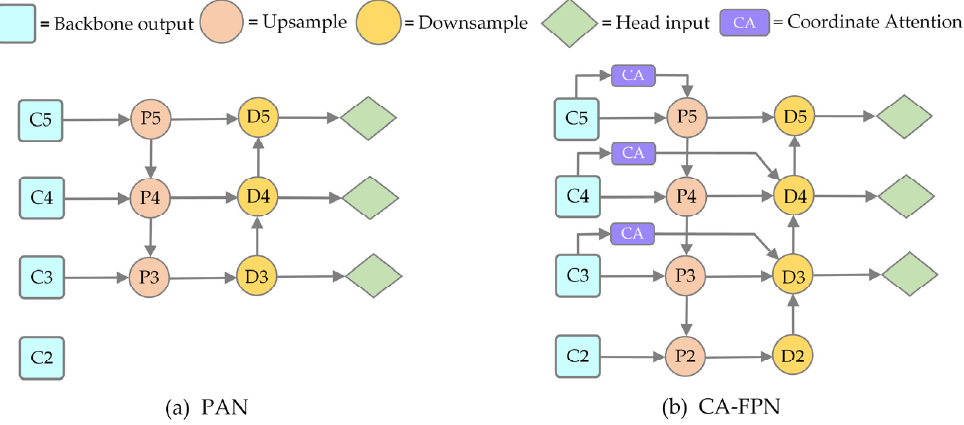
Figure 7. Comparison of feature fusion networks in YOLOv5s and IPD-Net.